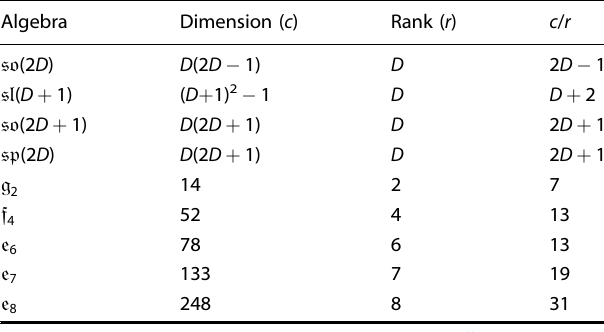
Table 1. Simple Lie algebras: c denotes an algebra ’ s dimension, and r denotes the